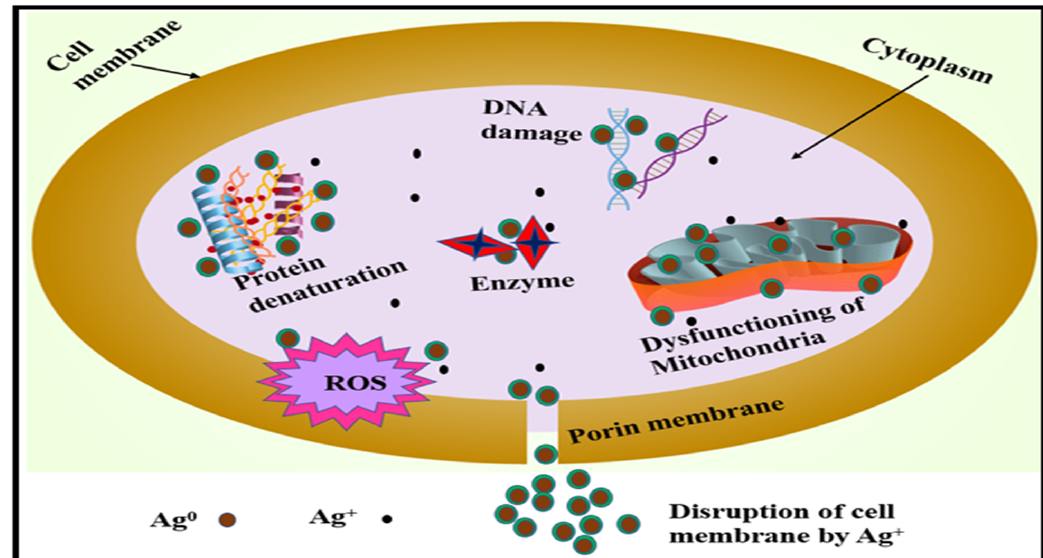
Figure 15. AgNPs mechanism of action for antimicrobial activity. Ag + ions are released from AgNPs during the redox reaction by exchanging electrons and ROS free radicals to react with DNA, protein enzymes, and mitochondria.